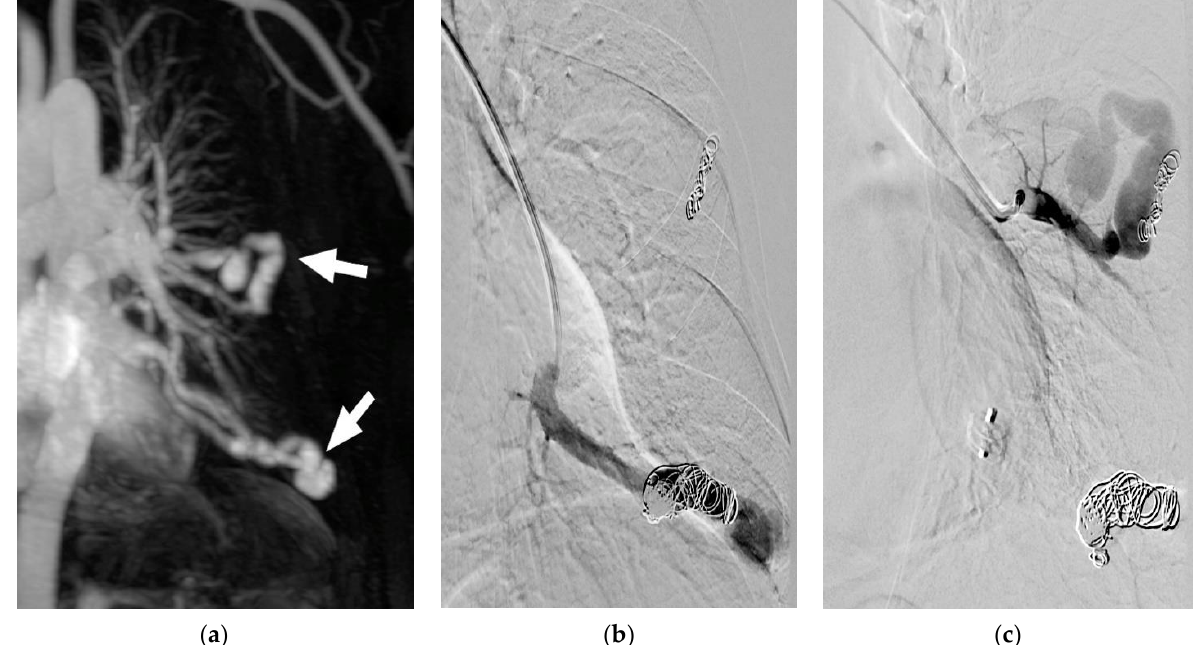
Figure 3. ( a – c ) Re-perfused PAVM after previous treatment elsewhere. Contrast-enhanced MRA ( a ) shows two large, re-perfused PAVMs (arrows) with early enhancement of the draining vein. In ( b ) the DSA of one re-perfused PAVM is shown, depicting insufficient dense packing of coils resulting in reperfusion of the vessel. No guide wire should be used, since small thrombi from the coils might be mobilized and lead to systemic emboli. In ( c ) the second re-perfused PAVM is demonstrated, showing only small coils at the wall of the vessel. Embolization was performed proximal to the treated vessel segment to avoid possible migration of the coils.